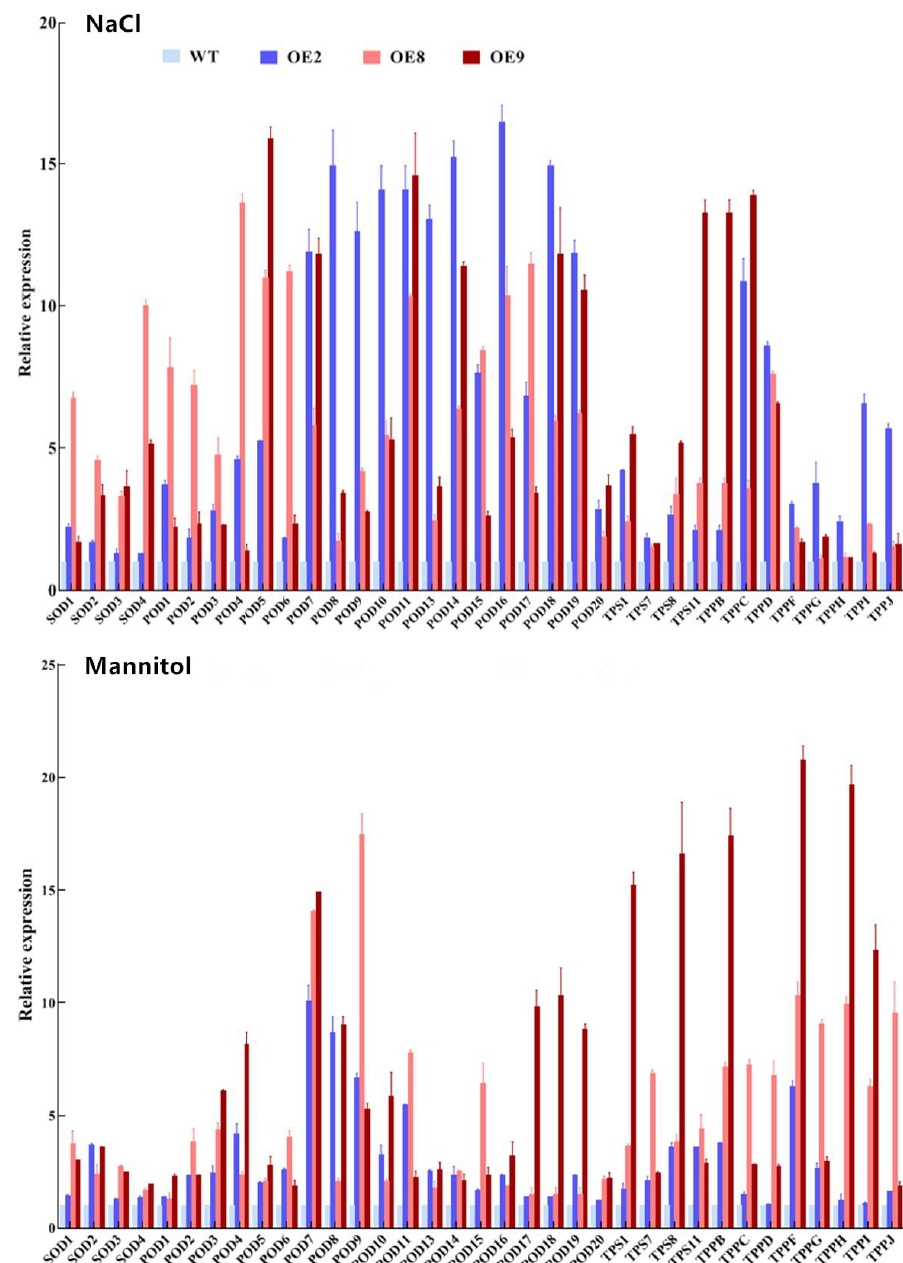
Figure 5. The expression pattern of the SOD , POD , TPS and TPP genes in transgenic and WT Arabidopsis plants. Four-week-old seedlings of transgenic lines and WT plants were treated with 150 mM NaCl or 200 mM mannitol for 24 h and were harvested for qRT-PCR analysis. The transcription levels of SODs, PODs , TPSs and TPPs in WT plants under the same conditions were set to 1 to calculate their expression in transgenic plants. The error bars were calculated from three replicates.